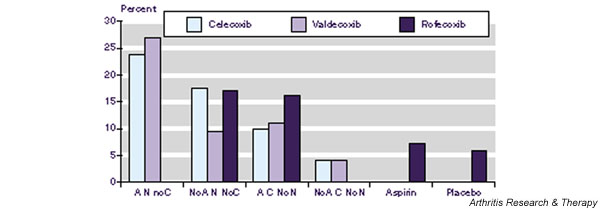
Endoscopically identified ulcers after treatment of arthritis with placebo, low-dose aspirin, NSAID, coxibs, and combinations. A, aspirin; N, NSAID; NSAID, nonsteroidal anti-inflammatory drug; C, coxib.